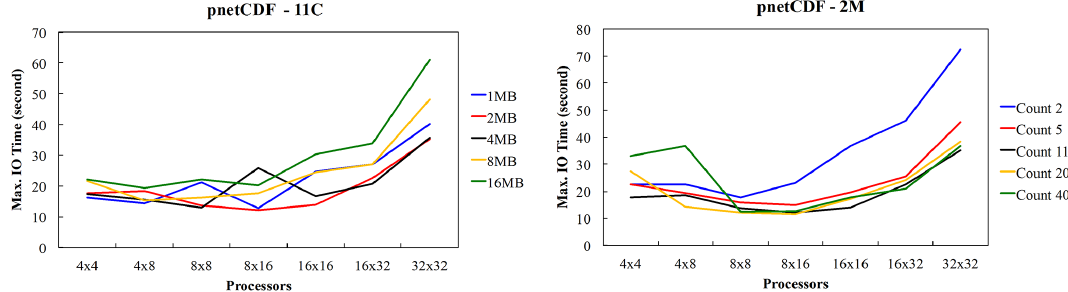
Figure 9. The impact of stripe count and size on parallel netCDF I/O performance on the CONUS domain. Left: various stripe sizes with fixed 11-stripe counts. Right: various stripe counts with fixed 2MB stripe size.